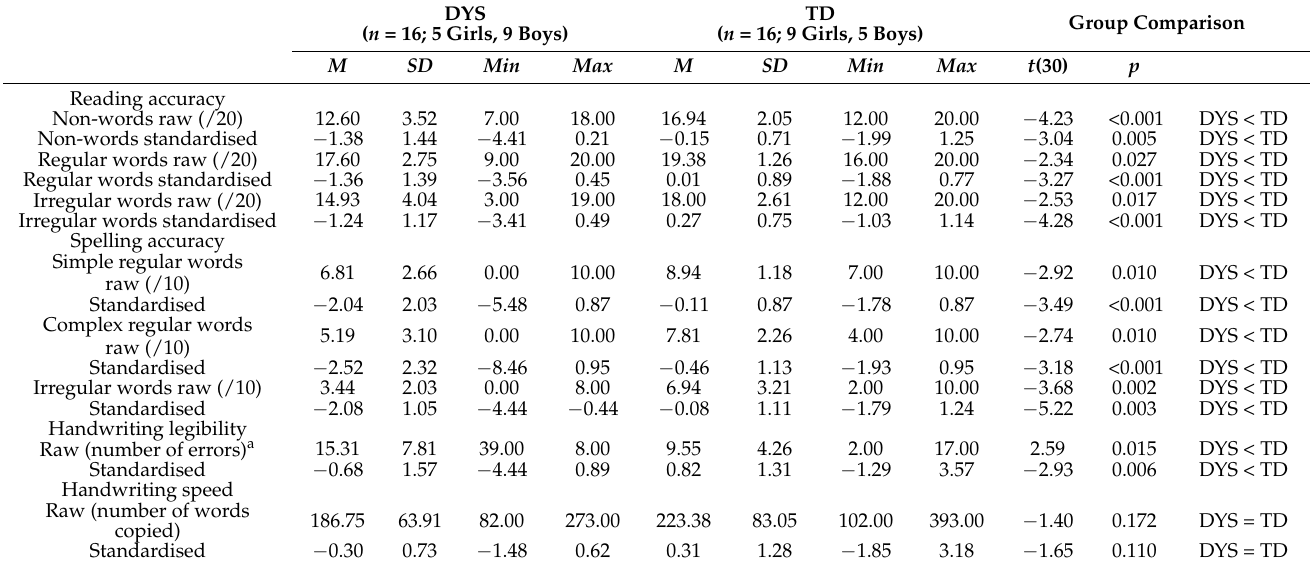
Table 1. Participants scores on behavioural tasks and statistical group comparison. DYS TD Group Comparison ( n = 16; 5 Girls, 9